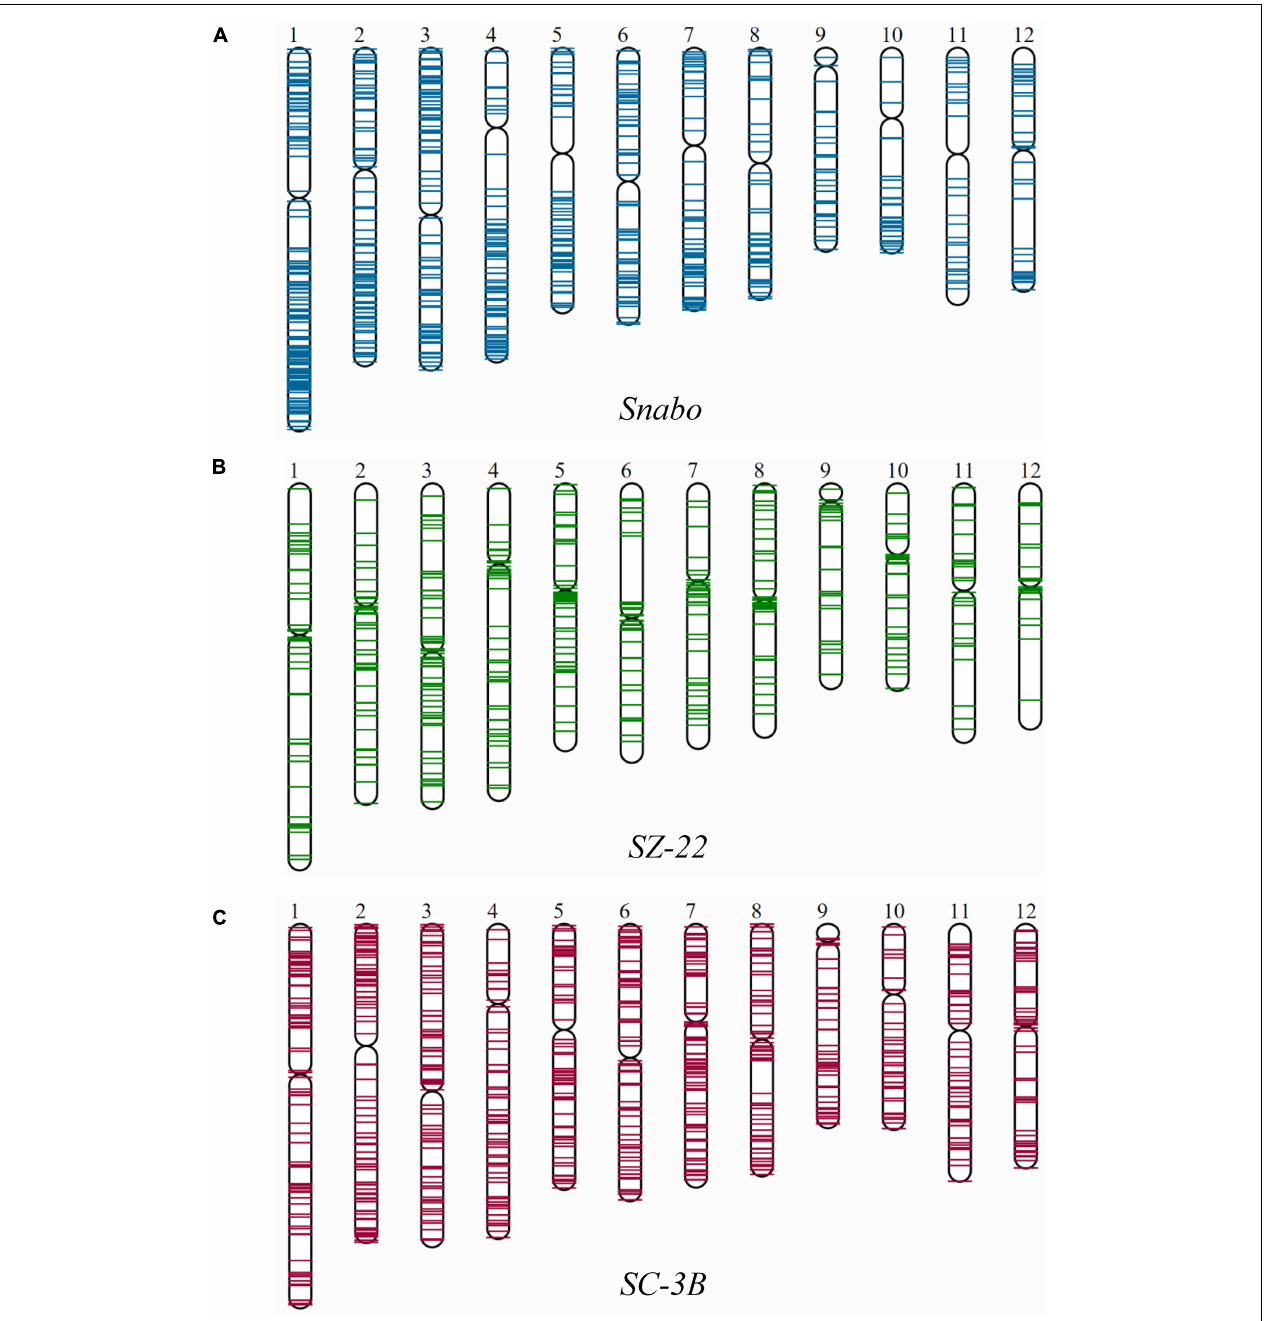
FIGURE 2 | The distribution of singletons from individual TE family on 12 rice chromosomes. Only three representative TE families were shown, which exhibited distinct distribution patterns on rice chromosomes. (A) The Snabo family was observed to be inclined to integrate into the chromosomal arm region compared to the pericentromeric region by mapping the 811 singletons to 12 rice chromosomes; (B) the SZ-22 family was observed to be biased toward the pericentromeric regions by mapping the 494 singletons in the family; (C) the SC-3B family showed no obvious insertion preference between the two chromosomal